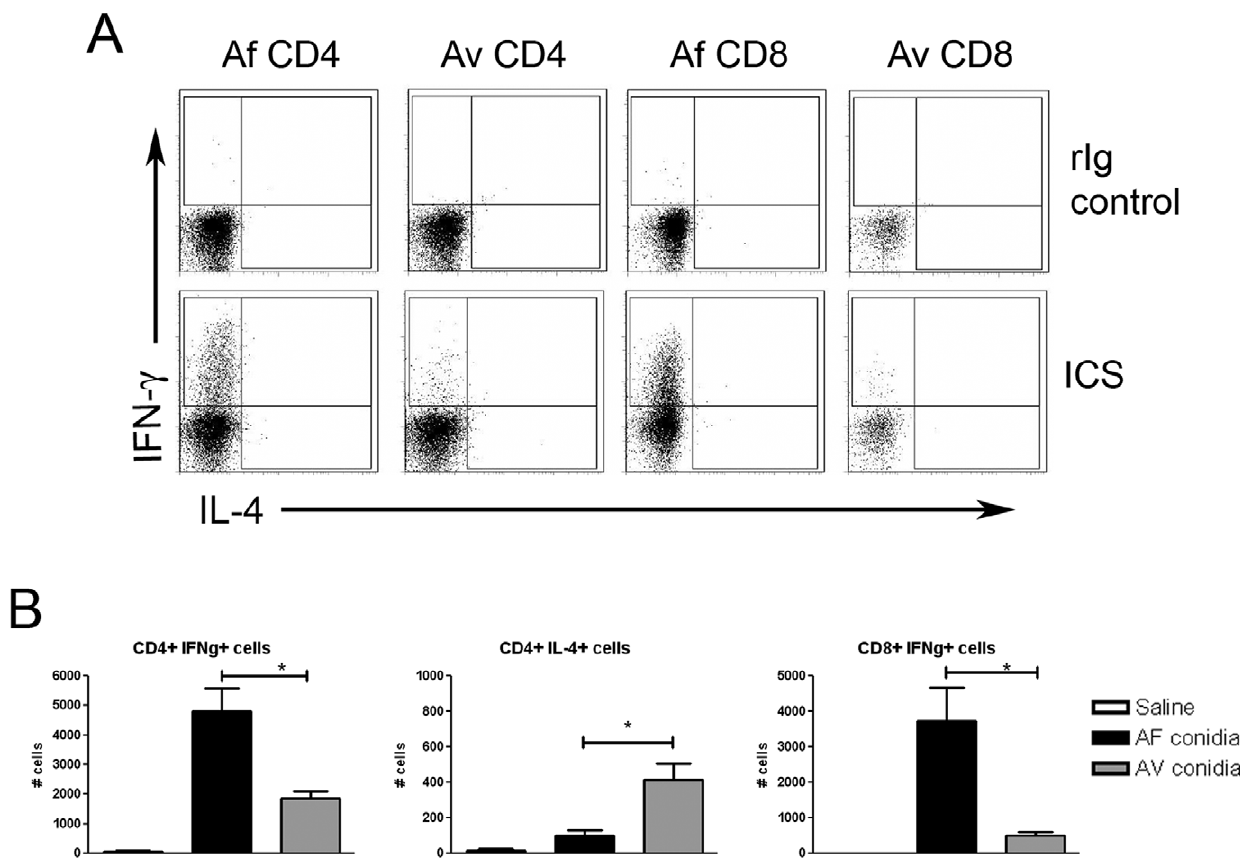
Figure 2. BALF T-cell cytokine production after repeated aspiration of Aspergillus conidia. A, flow cytometric dot plots of IFN- c and IL-4 production in BALF CD4 and CD8 T cells. Representative dot plots are from parent gates similar to those depicted in Figure 1D. B, Total # of IFN- c and IL-4-producing CD4 + T cells and IFN- c -producing CD8 + BALF T cells. Data depicted in B are a summary of two experiments with 6–11 mice per group. *p , 0.05 .